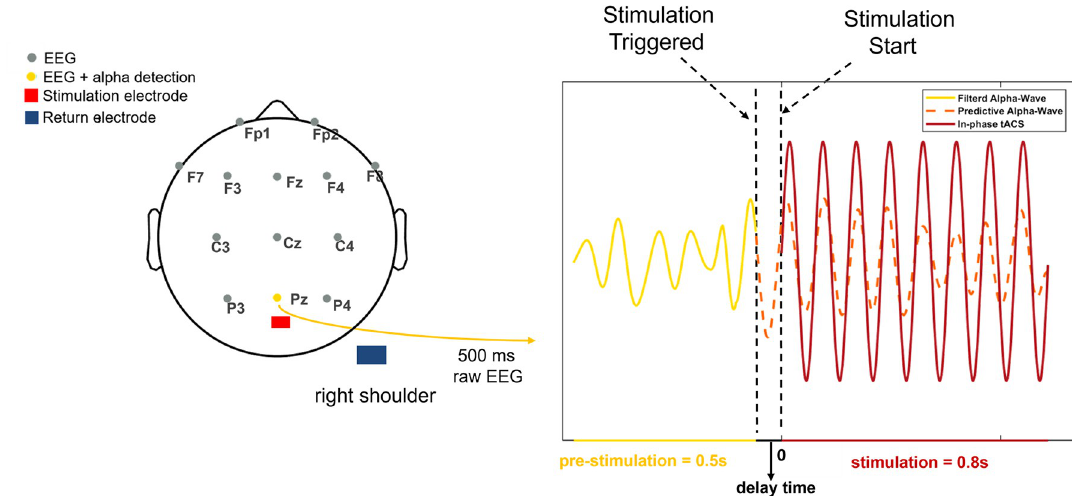
Fig 2. Illustration of the online phase-corrected tACS system. The left panel shows a standard 10–20 electrode system used in the experiment; the right panel shows an example of alpha-wave detection and the application of in-phase tACS. The stimulation electrode (shown with the red rectangle in the left panel) was placed over the central parietal-occipital cortex (between the Pz electrode and Oz electrode), with the return electrode over the right shoulder (shown with the blue rectangle in the left panel). The raw EEG data at the retention subprocess of the Sternberg task, as measured from the Pz electrode, was stored in a moving time window of 500 ms with a 10 ms step. This signal was filtered within the frequency range of IAF ± 2 Hz (shown with the dark yellow solid line) in real time. When 2 consecutive peaks exceeding the threshold were detected (note that the threshold was determined using Baseline EEG data), stimulation was triggered; subsequently after a specific delay time, in-phase tACS (shown in dark red) was initiated and lasted for 0.8 s. The dark orange dashed line shows the alpha wave after the triggering of stimulation (please note that it is not recorded due to tACS artifacts). The illustrative waveforms in the figure do not represent the actual size. EEG, electroencephalogram; IAF, individual alpha frequency; tACS, transcranial alternating current